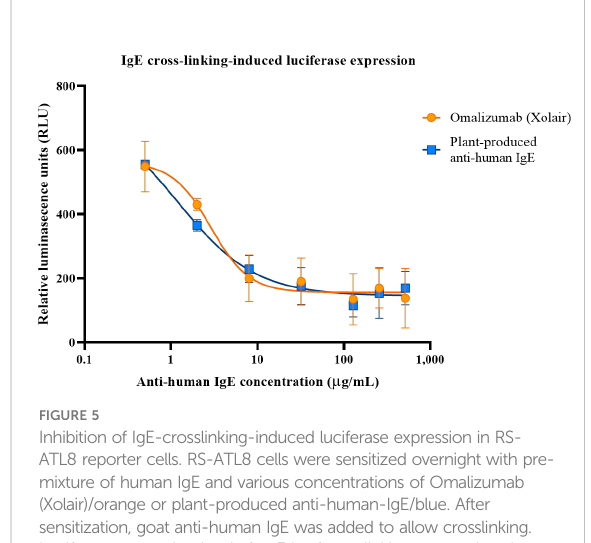
FIGURE 5 Inhibition of IgE-crosslinking-induced luciferase expression in RS- ATL8 reporter cells. RS-ATL8 cells were sensitized overnight with pre- mixture of human IgE and various concentrations of Omalizumab (Xolair)/orange or plant-produced anti-human-IgE/blue. After sensitization, goat anti-human IgE was added to allow crosslinking. Luciferase expression level after 3 h of crosslinking was analyzed. Data are expressed as mean ± SD of the duplicated-well readings of 3 independent experiments. The difference in RLU generated by plant produced anti-human-IgE and Xolair was analyzed by Mann-Whitney test (p > 0.05) in every